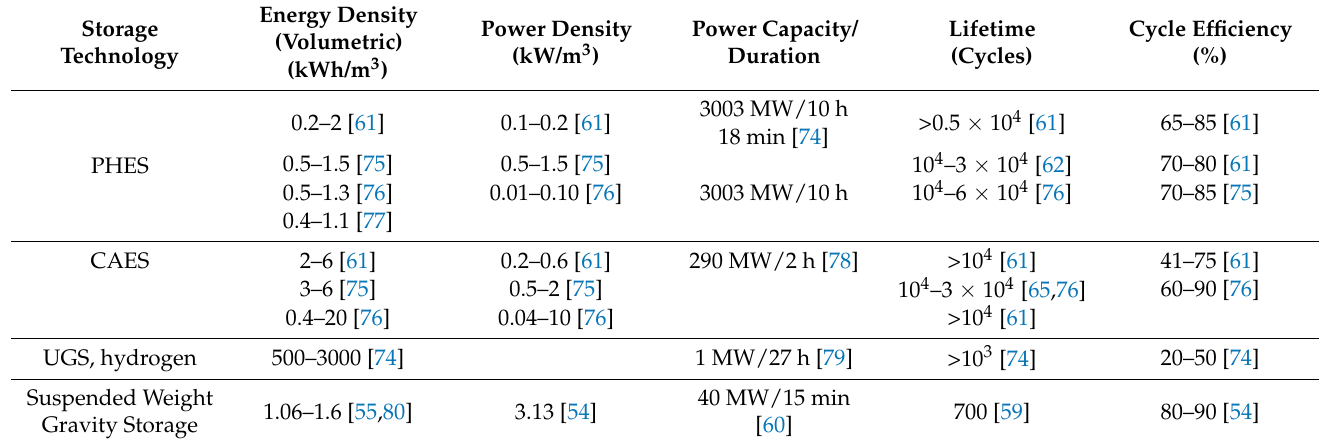
Table 4. Energy storage technology, PHES, CAES, UGS and Suspended